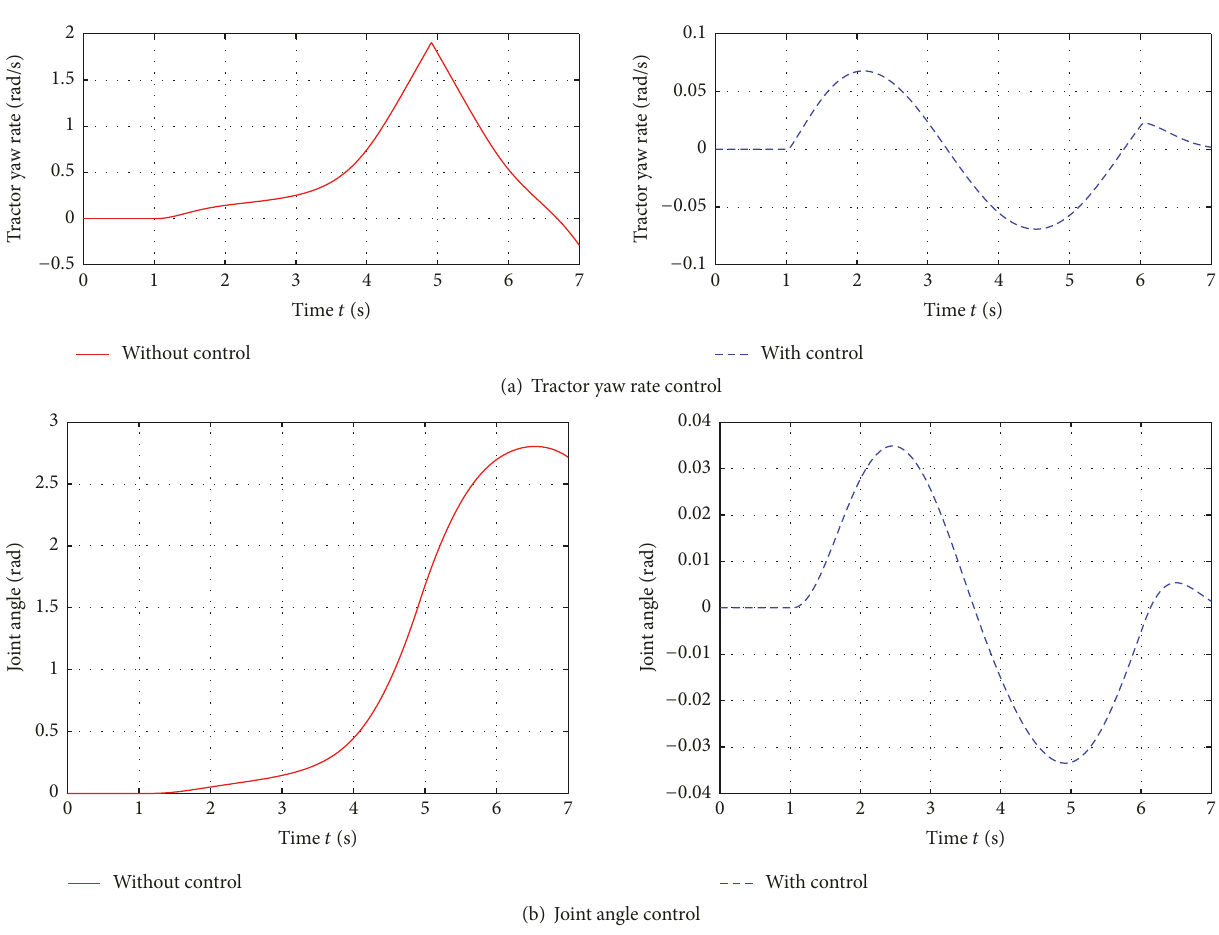
Figure 11: Typical contract of vehicle dynamic variables in critical single-lane changing.